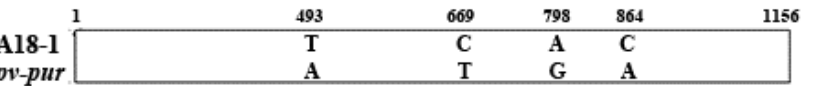
Figure 8. Sequence alignment diagram of Phvul.006G018800 in wild type ‘A18-1’ and purple mutant ‘ pv-pur ’